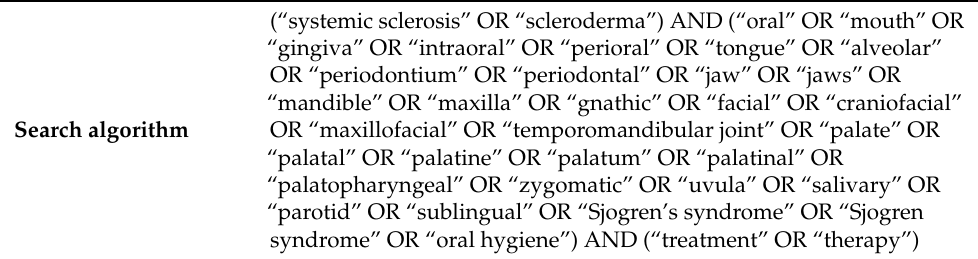
Table 2. Search algorithm used.